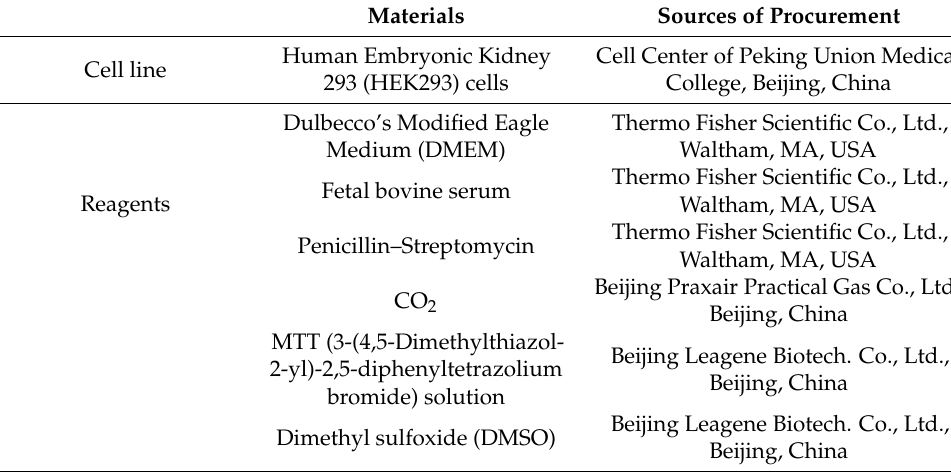
Table 1. Materials and their sources of procurement used in this